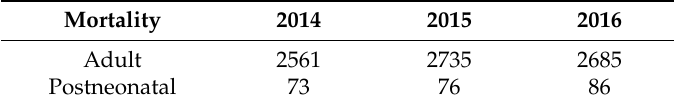
Table 3. Adult and postneonatal mortalities for three years (2014–2016). Mortality